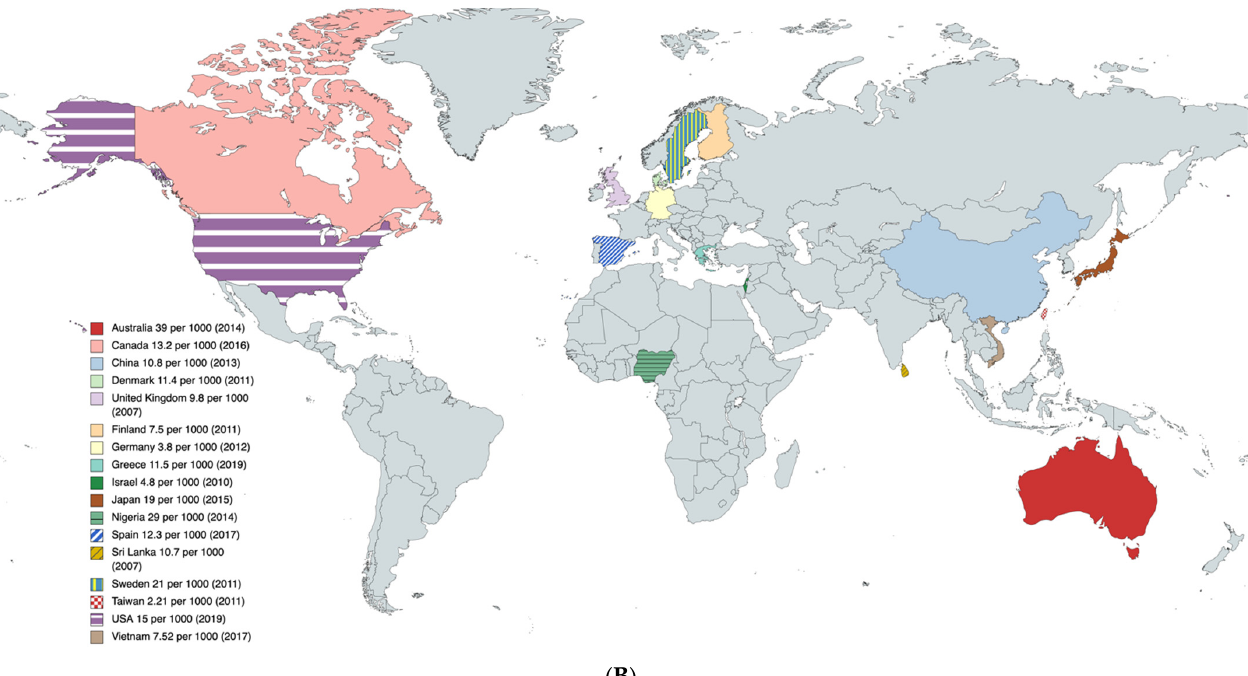
Figure 1. Prevalence (estimate per 1000) of autism spectrum disorders (ASD) in the world. ( A ) Prevalence trend for select countries; ( B ) Worldwide prevalence by year. Created with Mapchart.net.